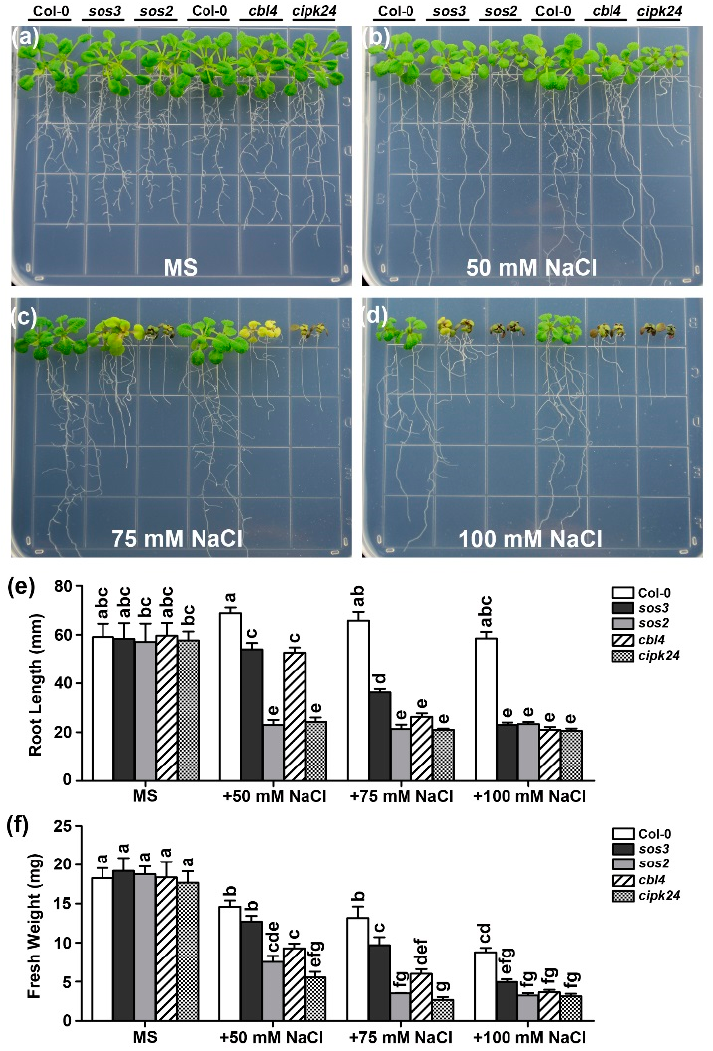
Figure 1. The cbl4 mutant plants are more sensitive to external Na + than sos3 mutant plants. ( a–d ) Growth phenotype of Col-0, sos3 , sos2 , cbl4 and cipk24 under different concentrations of external NaCl. Five-day-old wild type and mutant seedlings were transferred onto the Murashige and Skoog (MS) medium or MS supplemented with 50 mM, 75 mM and 100 mM NaCl. Photographs were taken on the 14th day after the transfer; ( e ) length of primary roots and ( f ) fresh weight of seedlings on the 14th day after the transfer. Data are presented as the mean ± Standard Error(SE) of triplicate experiments. Values labeled with di ff erent letters are significantly di ff erent ( p <